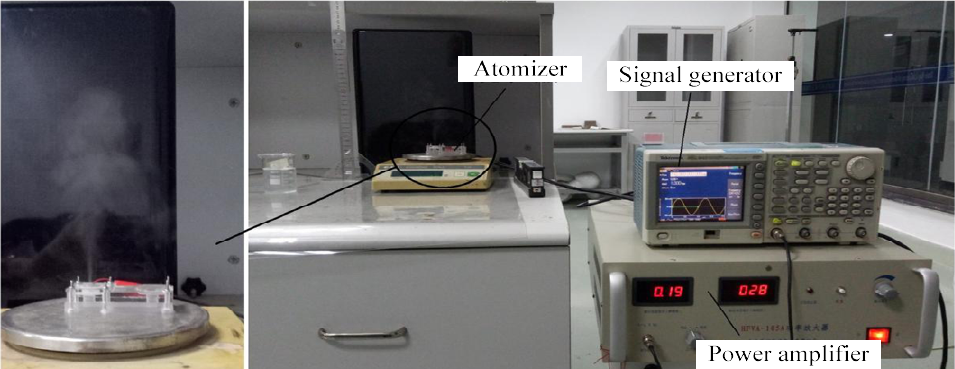
Figure 8. The equipment used for the measurement of the atomization rate.